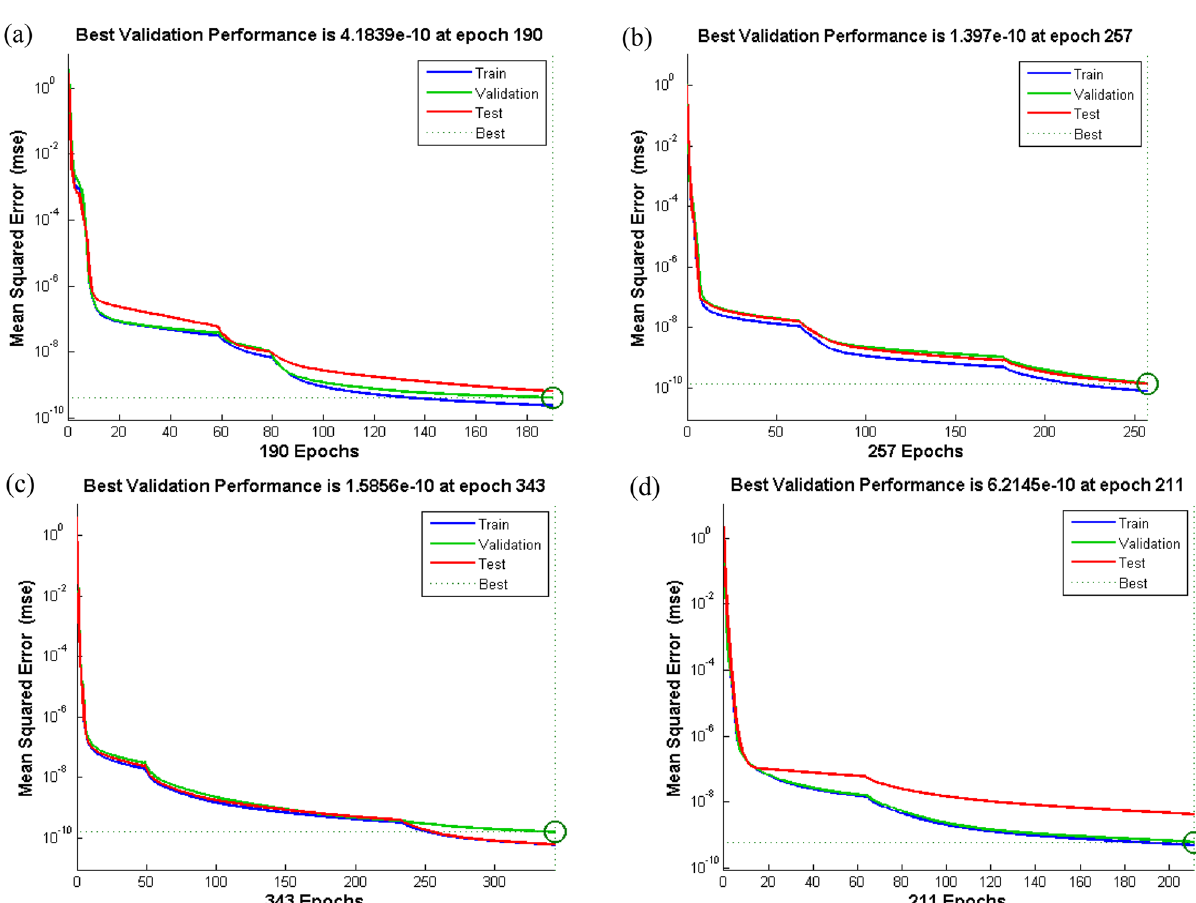
Figure 9. Performance curve of case study 1: scenario1 ( a ) case 1, ( b ) case 2, ( c ) case 3 and ( d ) case